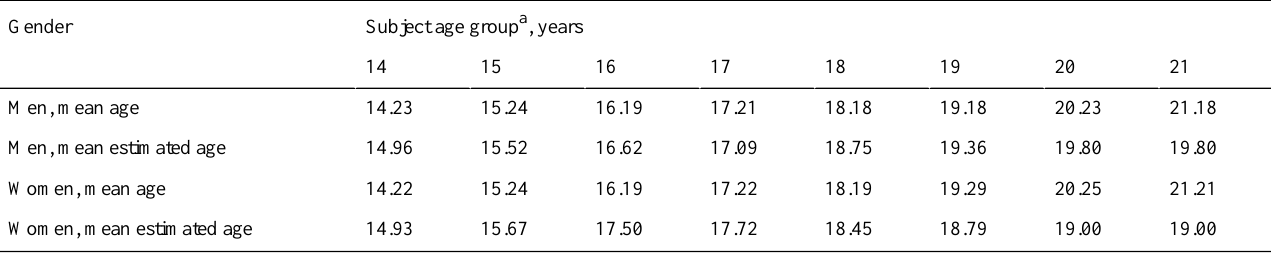
Table 3. Mean age and mean estimated age per age group by the best-performing model, GoogLeNet, on male and female